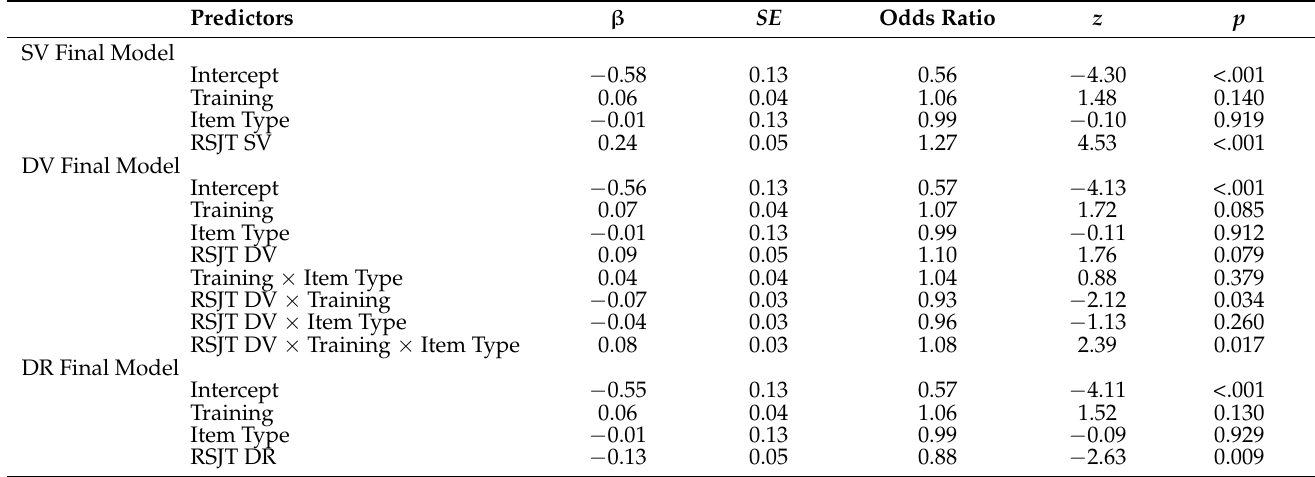
Table 7. Predicting figural analogy accuracy with RSJT measures, training, and item type.